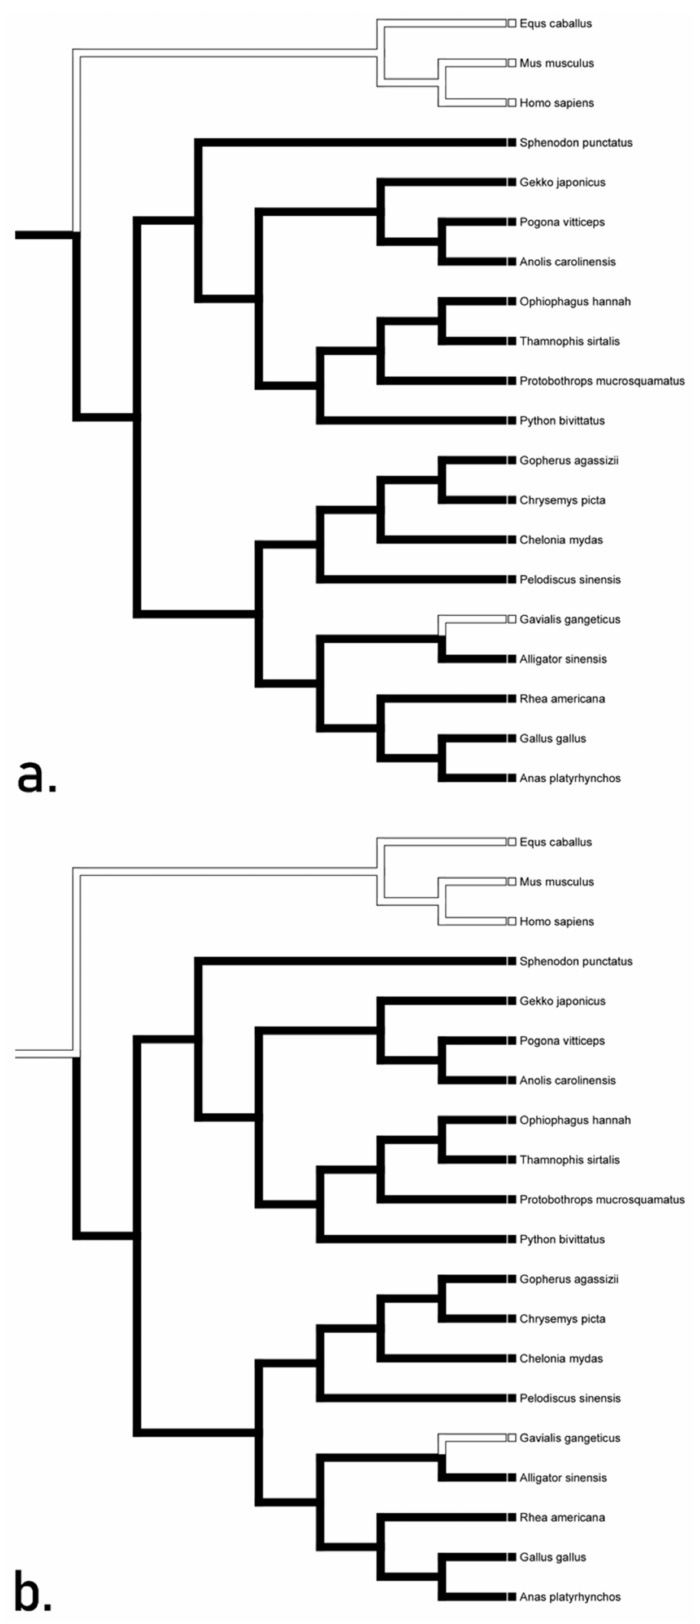
Figure 6. Character optimization of TLR 21 using accelerated transformations ( a ) and delayed ( b ) exhibiting unequivocal loss in Gavialis and presence in the basal